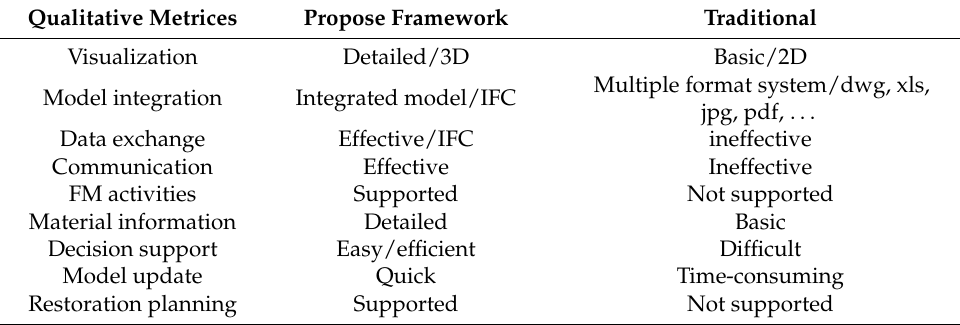
Table 2. Qualitative evaluation of the proposed framework. Qualitative Metrices Propose Framework Traditional